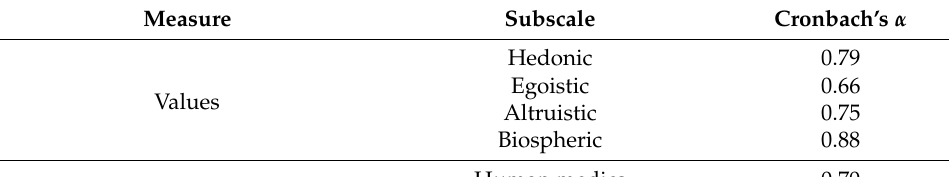
Table 8. Reliability Statistics for Values and Beliefs